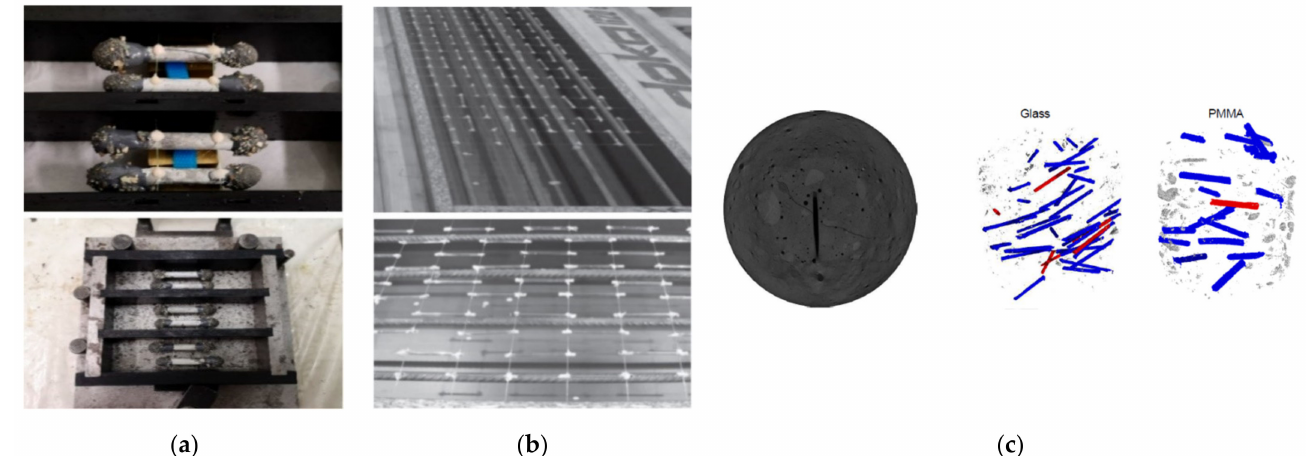
Figure 5. ( a ) Manual placement of two cementitious capsules in a small-scale mortar mould [22]. ( b ) Manual placement of glass capsules onto a network of wires in a large-scale concrete beam mould. Reproduced with permission from [49]. Copyright 2016, Elsevier. ( c ) Reconstructed CT scan of a sliced concrete core with a glass capsule crossed by a crack ( left ) and the 3D distribution of capsules in the concrete cores as a result of direct addition of capsules during concrete mixing ( right ). Reproduced with permission from [46]. Copyright 2018, Elsevier. Table 1. Different microcapsule materials with the corresponding parameters and characteristics used in concrete application.